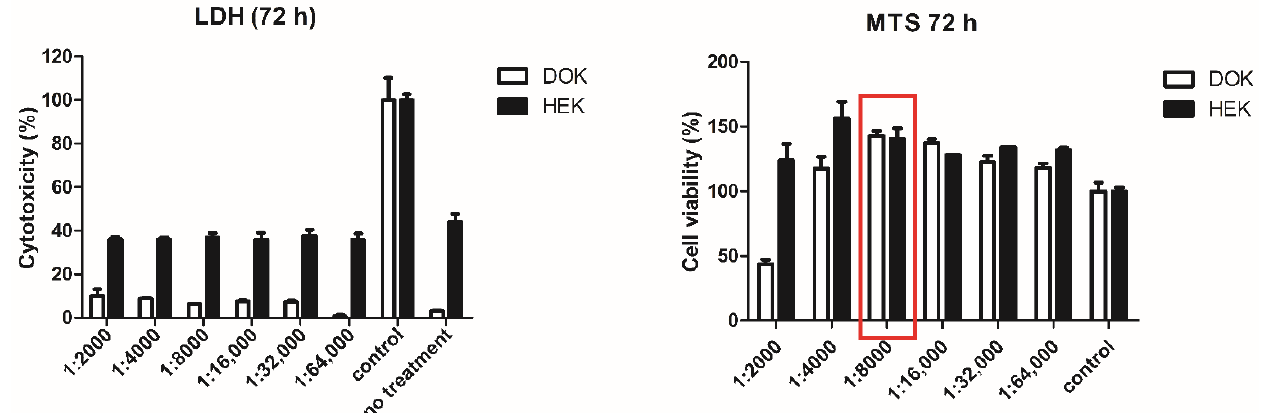
Figure 2. Assessment of toxicity of sea-buckthorn seed oil. Normal human keratinocytes (HEK) and dysplastic keratinocytes were seeded at a density of 10,000 cells/well in 96 well plates and treated for three days with the indicated dilutions of sea-buckthorn seed oil. Cytotoxicity was assessed by lactate dehydrogenate (LDH) release in the cell medium and viability by MTS assay. LDH control is represented by the lysis control (100% mortality). The MTS control was represented by cells maintained in standard cell culture conditions. The highest non-toxic and pro-proliferative concentrations (highlighted in red) were chosen for further tests. Bars represent average of triplicates, calculated as percentage to control.